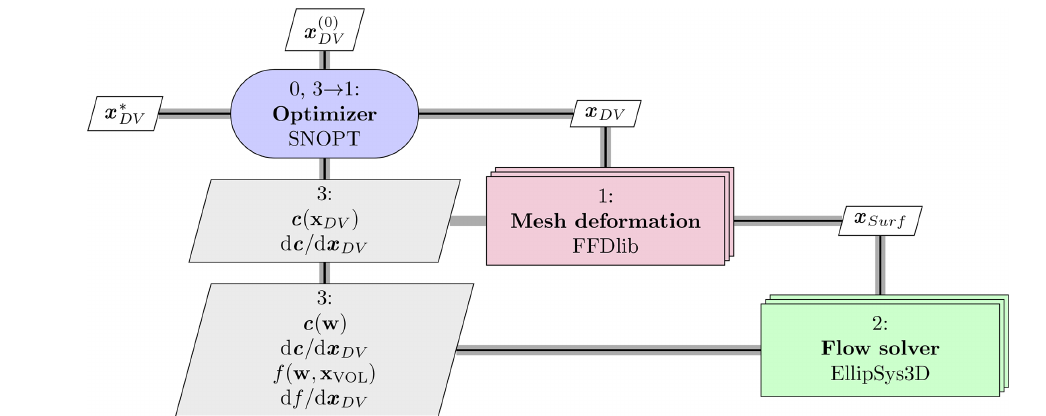
Figure 1. The FlowOpt framework when using a step-based approach for gradient